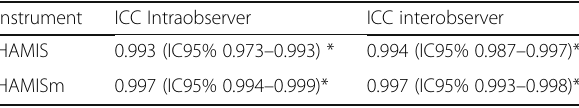
Table 3 Intraobserve and interobserver reliability for HAMIS-Br and